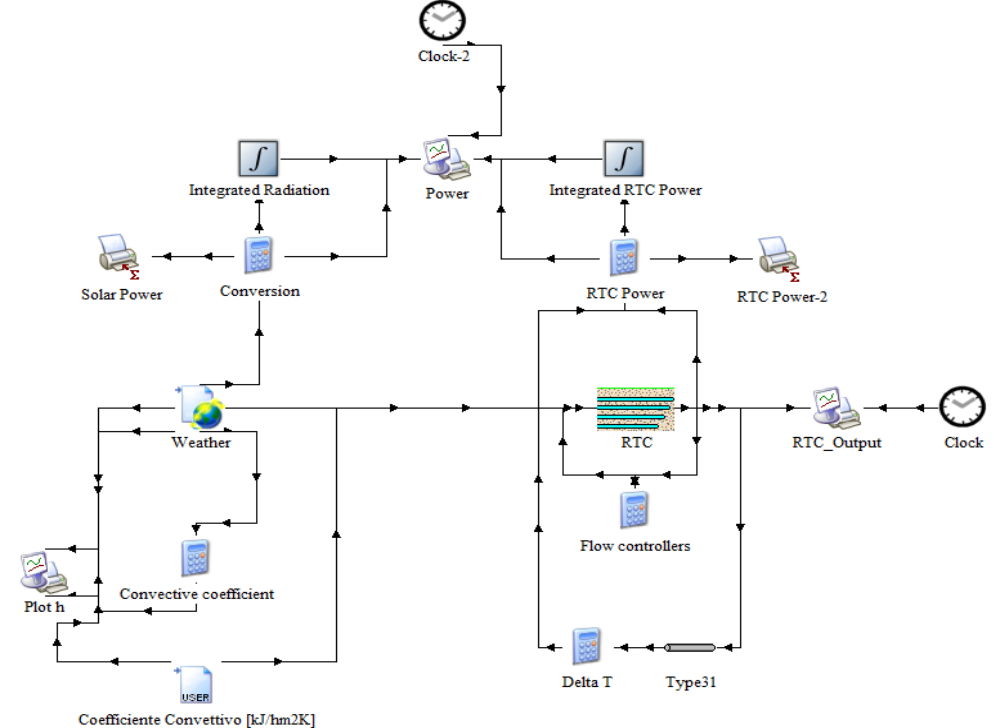
Figure 9. TRNSYS model schema.